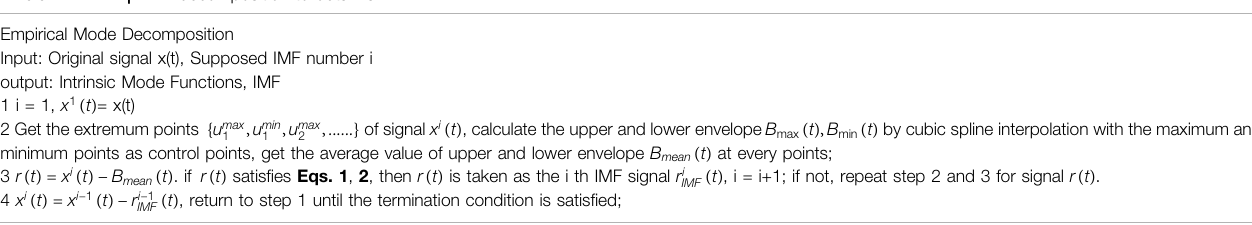
ALGORITHM 1 | EMD decomposition to obtain an